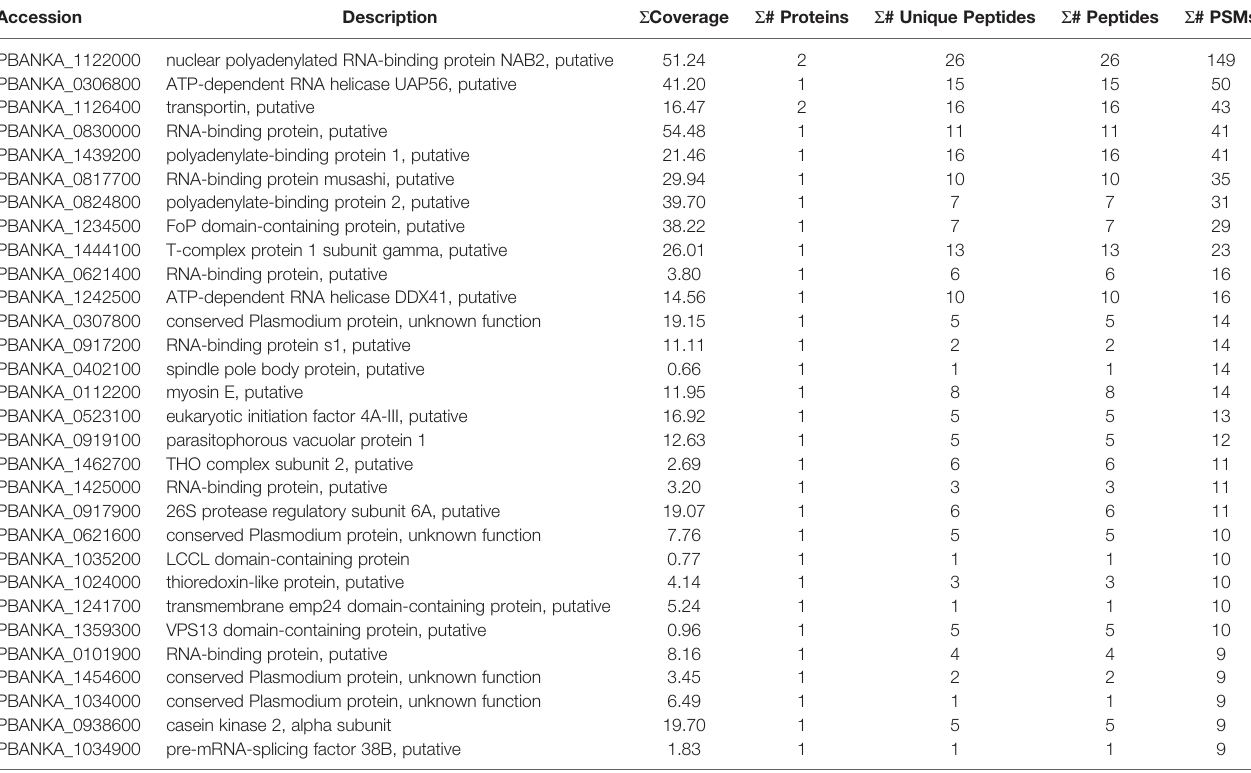
TABLE 2 | Results of immunoprecipitation coupled to mass spectrometry in NAB2::mCherry parasites. Accession